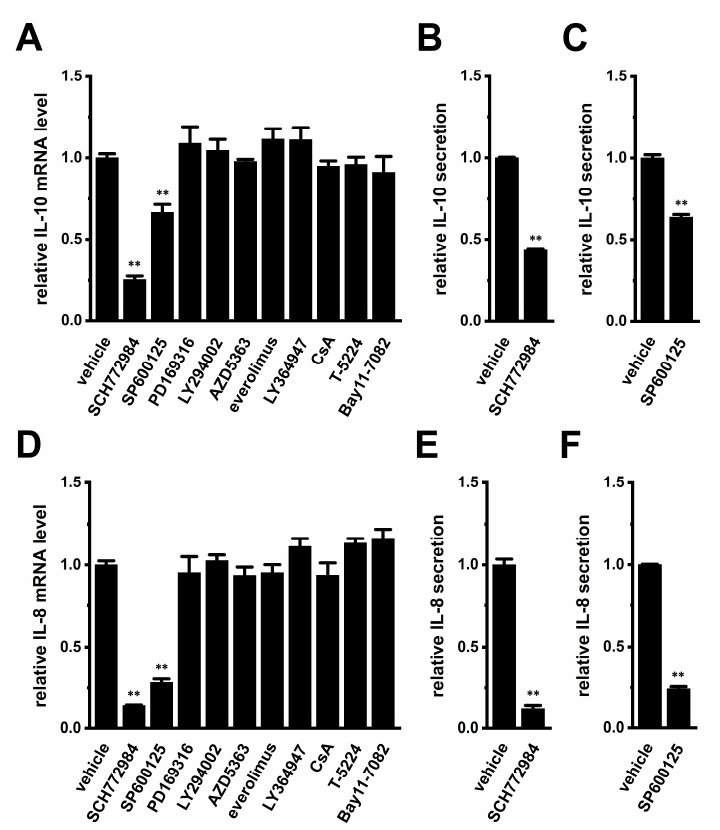
Figure 6. Effects of a 24 h treatment with various signaling pathway inhibitors on IL-10 and IL-8 expression and effects of the 24 h treatment with the ERK1/2 inhibitor, SCH772984 and JNK inhibitor, SP600125 on IL-10 and IL-8 secretion in THP-1-derived M 2 macrophages. ( A , D ): Real-time PCR examination of IL-10 ( A ) and IL-8 ( D ) expression in SCH772964 (1 μM)-, SP600125 (10 μM)-, PD169316 (10 μM)-, LY294002 (10 μM)-, AZD5363 (2 μM)-, everolimus (10 nM)-, LY364947 (10 μM)-, ciclosporin A (CsA, 1 μM)-, T-5224 (10 μM)-, and Bay11-7082 (10 μM)-treated THP-1-derived M 2 macrophages for 24 h. Relative mRNA expression in the vehicle control is expressed as 1.0 (n = 4 for each). ( B , C , E , F ): Quantitative detection of IL-10 ( B , C ) and/or IL-8 ( E , F ) secretion by an ELISA assay in SCH772964 ( B , E )- and SP600125 ( C , F )-treated THP-1-derived M 2 macrophages. Relative cytokine secretion in the vehicle control is expressed as 1.0 (n = 4 for each). **: p < 0.01 vs. the vehicle control.